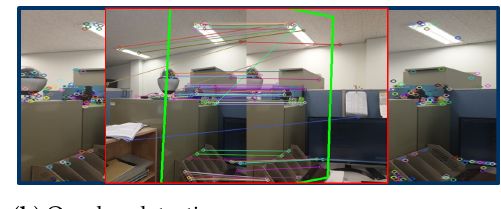
Figure 1. Feature matching. Parallel lines indicate good matches while nonparallel lines indicate bad matches; ( a ) feature matching between two consecutive frames; ( b ) overlap detection between two consecutive